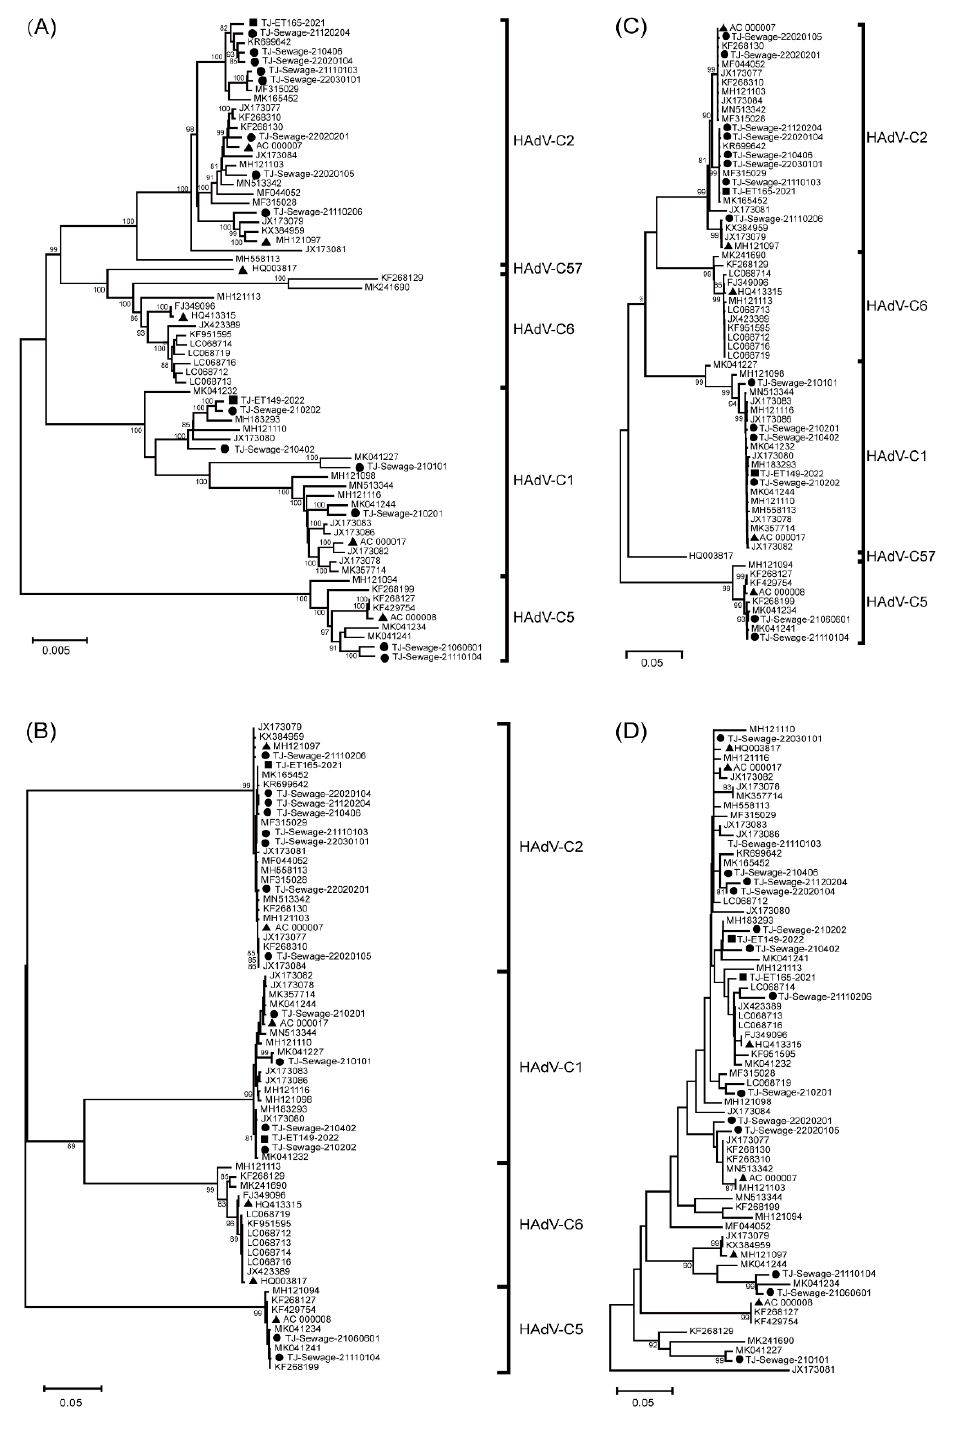
Figure 2. Phylogenetic trees based on the complete genome ( A ), fiber gene ( B ), hexon gene ( C ) and penton gene ( D ) of 68 HAdV-C sequences, including 16 Tianjin strains in this study and 52 reference strains from the GenBank. Tianjin sequences isolated from faeces are indicated with a black square, whereas sequences isolated from sewage are indicated with a black dot. Each prototype sequence is indicated with a black triangle. The trees were constructed using the Neighbour-joining method of MEGA 7.0 with 1000 bootstraps. HAdV-C, human adenovirus species